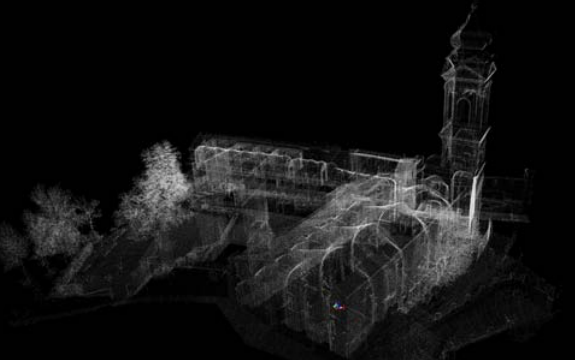
Figure 4. The ogival vault system inside the